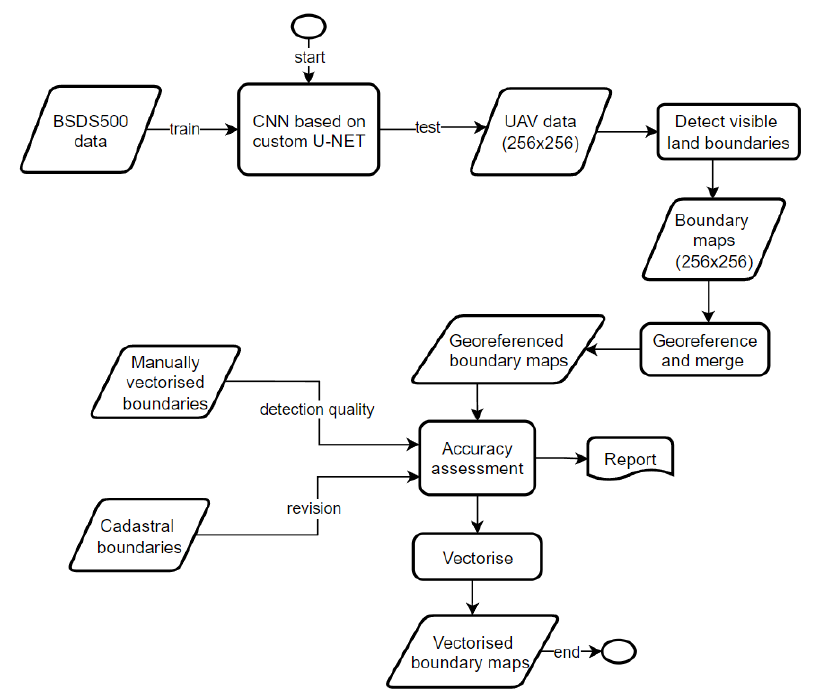
Figure 1. Generalised workflow applied in this